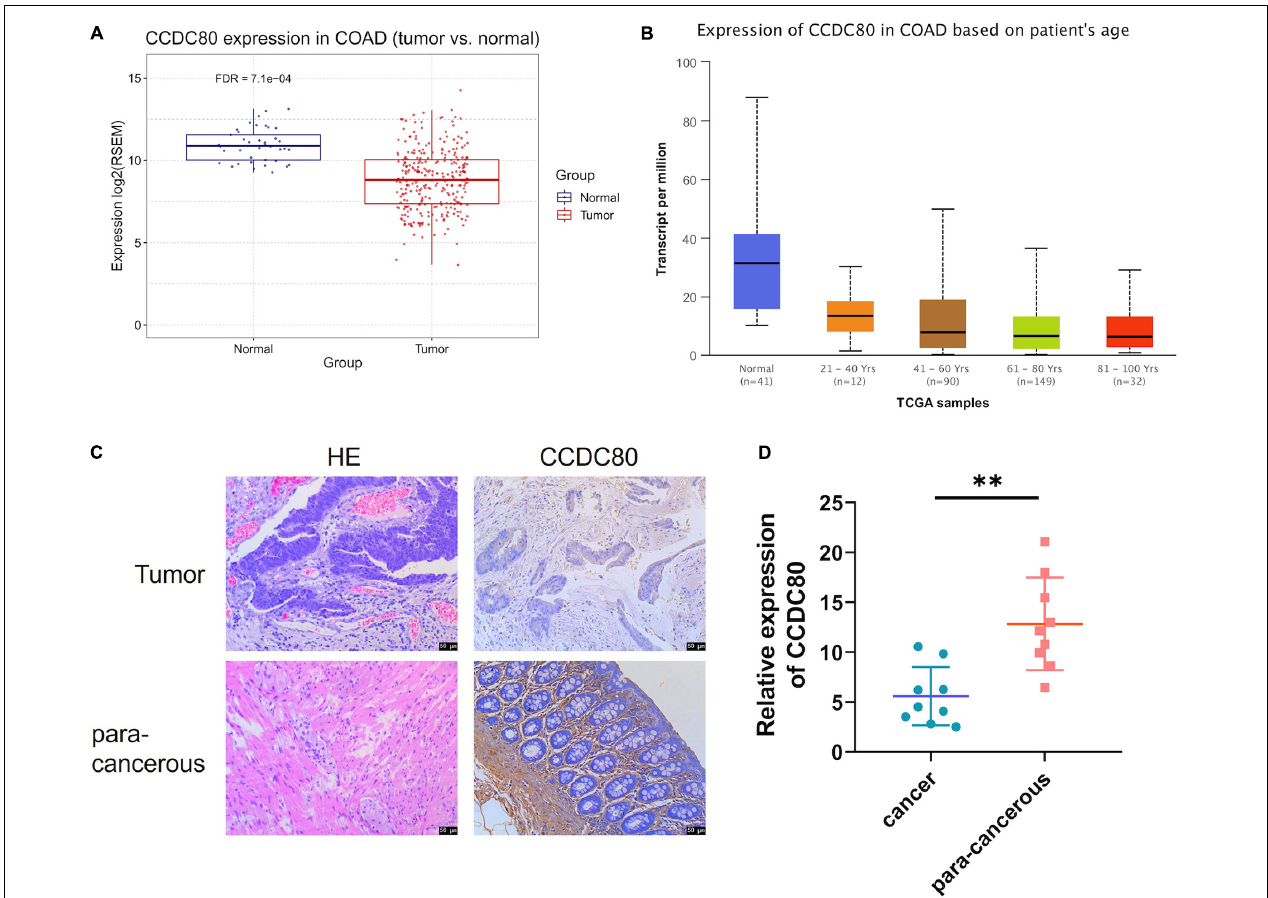
FIGURE 4 | Expression of coiled-coil domain containing 80 (CCDC80) decreases in colorectal cancer (CRC) tissues. (A) CCDC80 expressed in CRC and normal tissues. (B) CCDC80 expression in CRC in patients with different age stages. (C) The expression of CCDC80 in CRC and para-cancerous tissues as detected by hematoxylin-eosin (HE) and immunohistochemistry (IHC) strain. Bar = 50 µ m. (D) The positive expression of CCDC80 in CRC and para-cancerous tissues by IHC strain analyzed using the ImageJ software. ∗∗ p < 0.01.